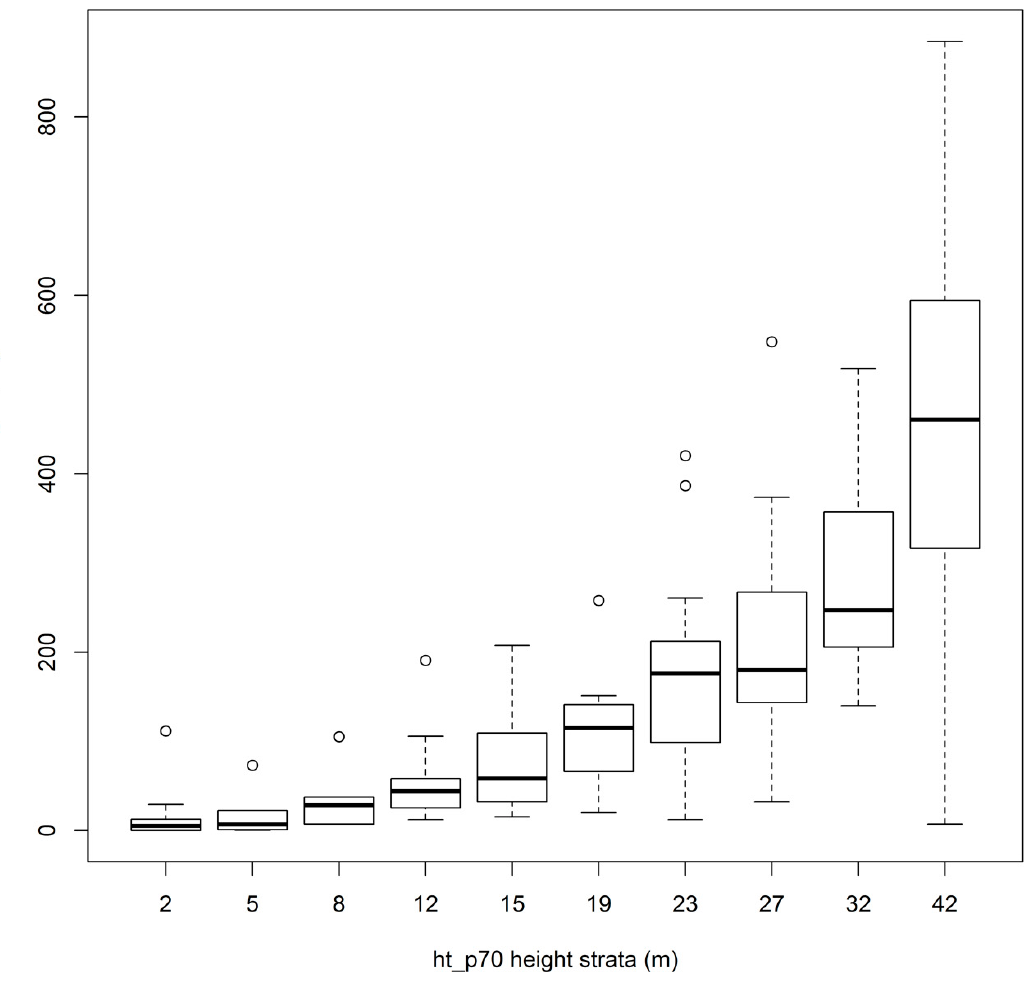
Figure 4. Box and whisker plot of height strata labeled with midpoint heights for ht_P70 using HPL coordinates and a lidar DTM. Horizontal bolded bars represent medians, box extents represent 25th and 75th percentiles, and extents of “whiskers” (dotted vertical lines with horizontal ends) represent 1.5 times the interquartile ranges. Points represent potential outliers which fall beyond the whiskers.